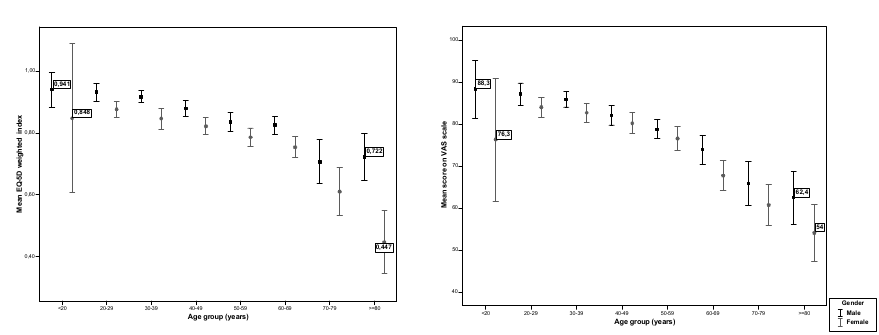
Figura 1 – Mean and 95% confidence interval for self-rated health status of respondents.